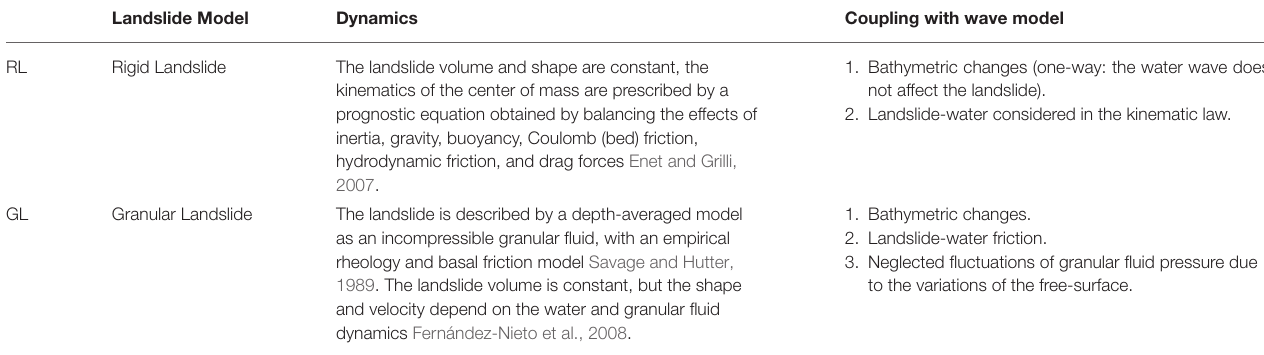
TABLE 1 | Different modeling approaches used in this work for the description of the landslide.